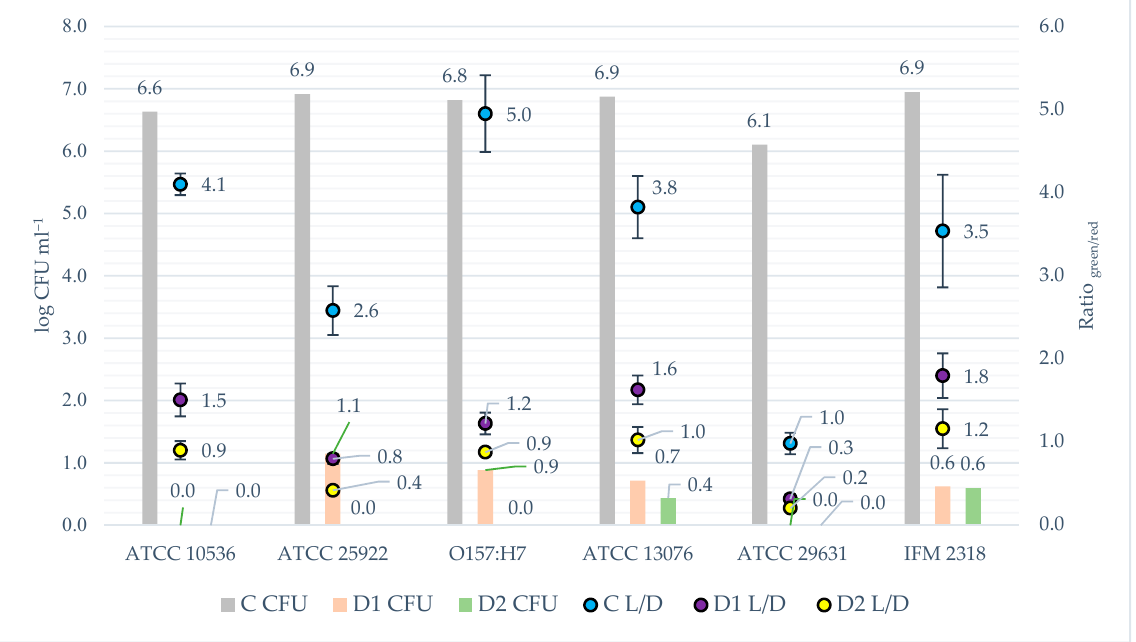
Figure 6. The survival of tested strains after disinfection procedure measured by fluorescence staining vs. CFU analysis. Explanations: L/D—LIVE/DEAD method = fluorescence staining; CFU—colony forming units method; bars refer to CFU results; dots refer to fluorescence staining analysis; C—control, not disinfected with any method; D1—disinfected with the 1st method; D2—disinfected with the 2nd method; DP1—disinfected with the 1st method + L. plantarum 299v; DP2—disinfected with the 2nd method + L. plantarum 299v. Table 3. Fluorescence intensity of gram-negative bacteria in analysed samples based on Ratio green/red . Sanitation Method